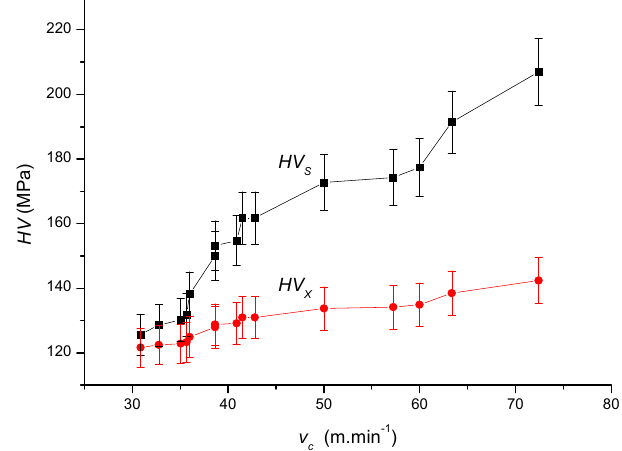
Figure 4. Dependence of the Vickers hardness on cutting speed ( HV S —substrate Vickers hardness; HV X —spray Vickers hardness).